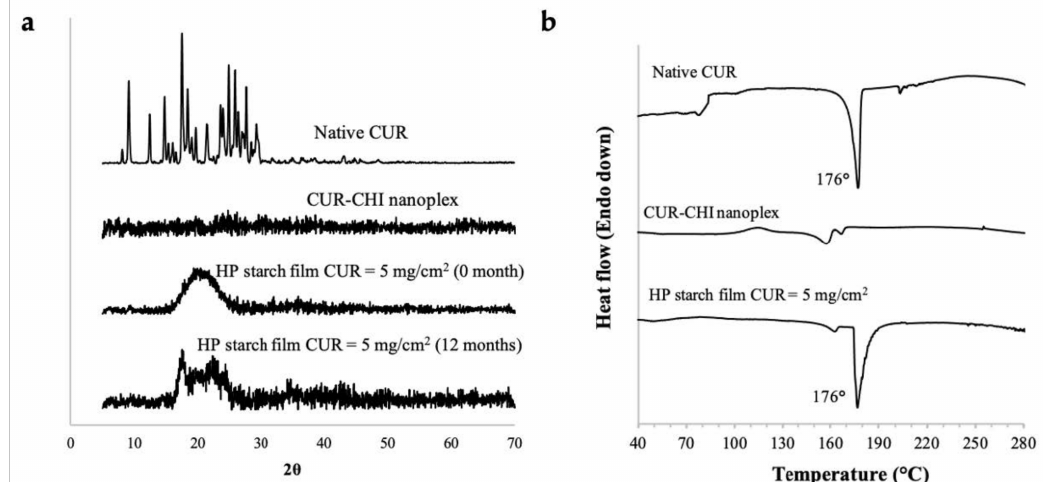
Figure 6. ( a ) PXRD; ( b ) DSC of the CUR–CHI nanoplex-loaded HP starch